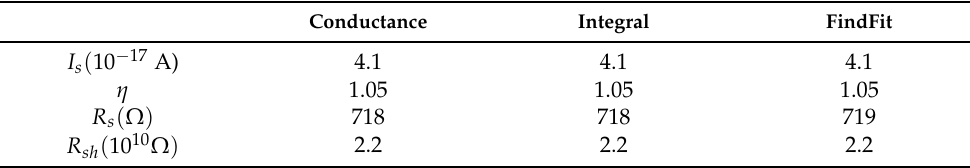
Table 2. Gold-gallium arsenide SBD physical parameters extracted by three different methods based on the experimental I–V